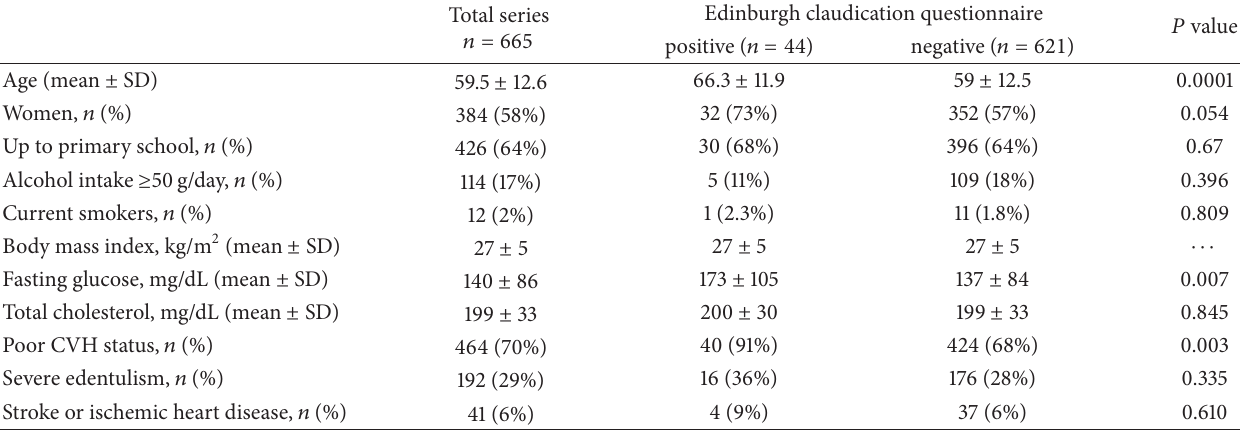
Table 5: Characteristics of Atahualpa residents aged ≥ 40 years according to the Edinburgh claudication questionnaire.